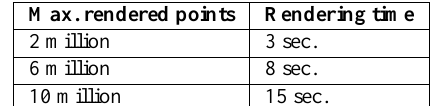
Table 1. Time for completing the rendering of one view using different budgets of points. As can be seen, the time for com- pleting the rendering for a single view is in the order of seconds. Please note that the user is free to navigate during this time since the refinement process is